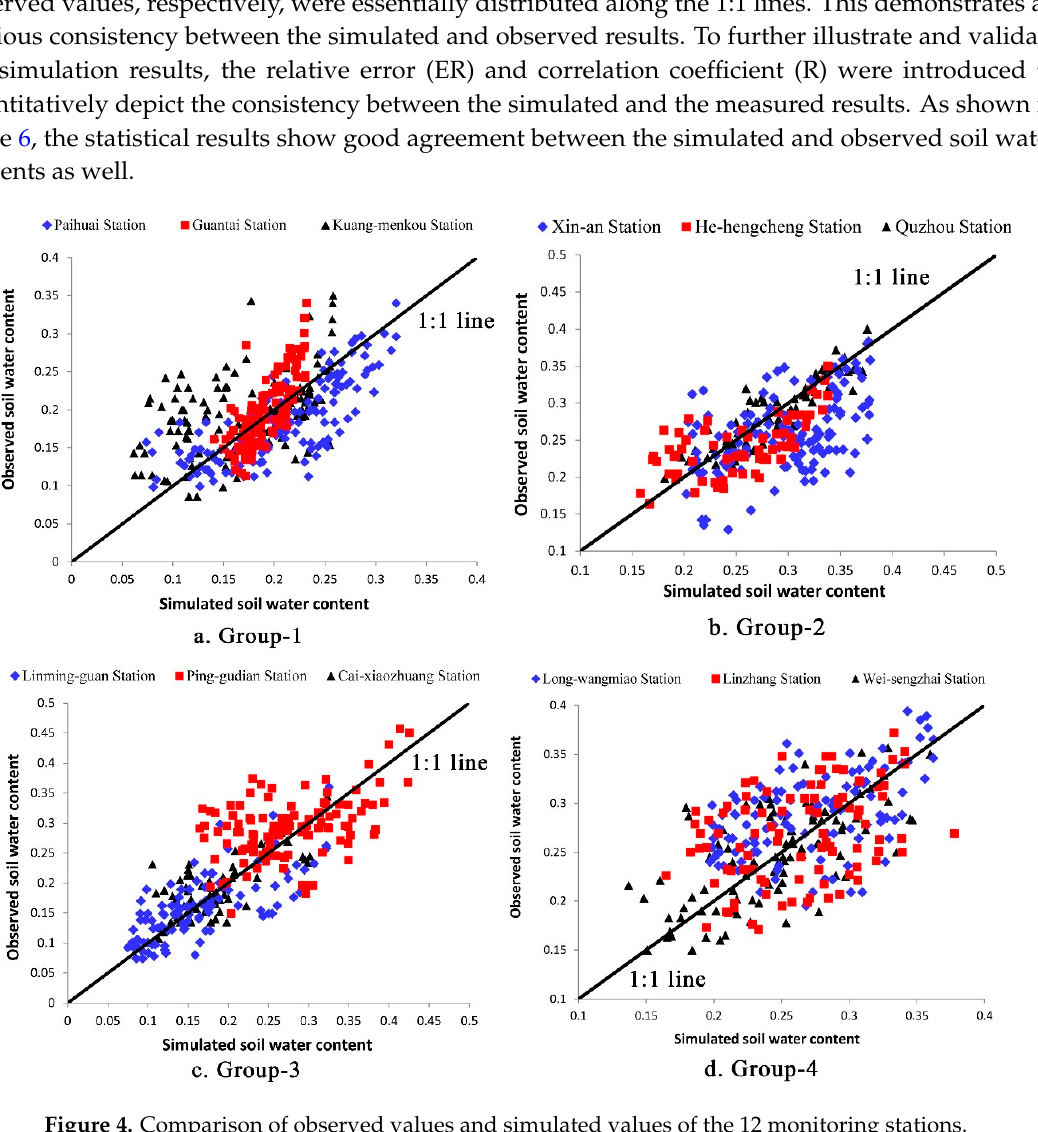
Figure 4. Comparison of observed values and simulated values of the 12 monitoring stations.